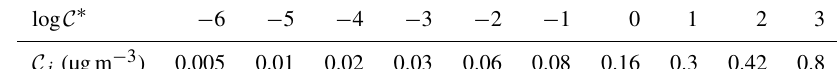
Table 2. Volatility distribution of SVOCs.